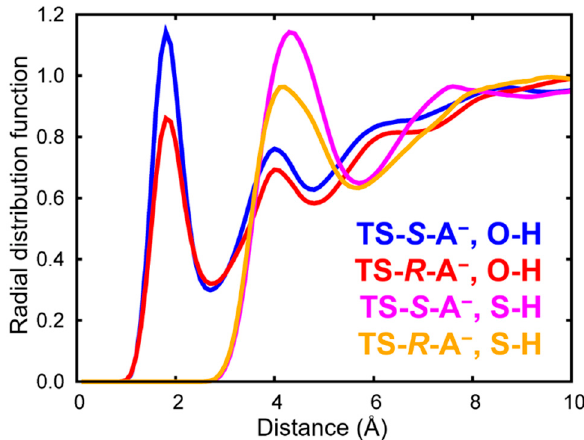
Figure 5. Calculated RDFs for the O or S (MeSO 3 − )-H (H 2 O) distances at x(H 2 O) = 0.3 volume fraction at TS- R -A − and TS- S -A − . The RDFs for the O-H distances at TS- R -A − and TS- S -A − and the S-H distances at TS- R -A − and TS- S -A − are shown in red, blue, orange, and purple, respectively.